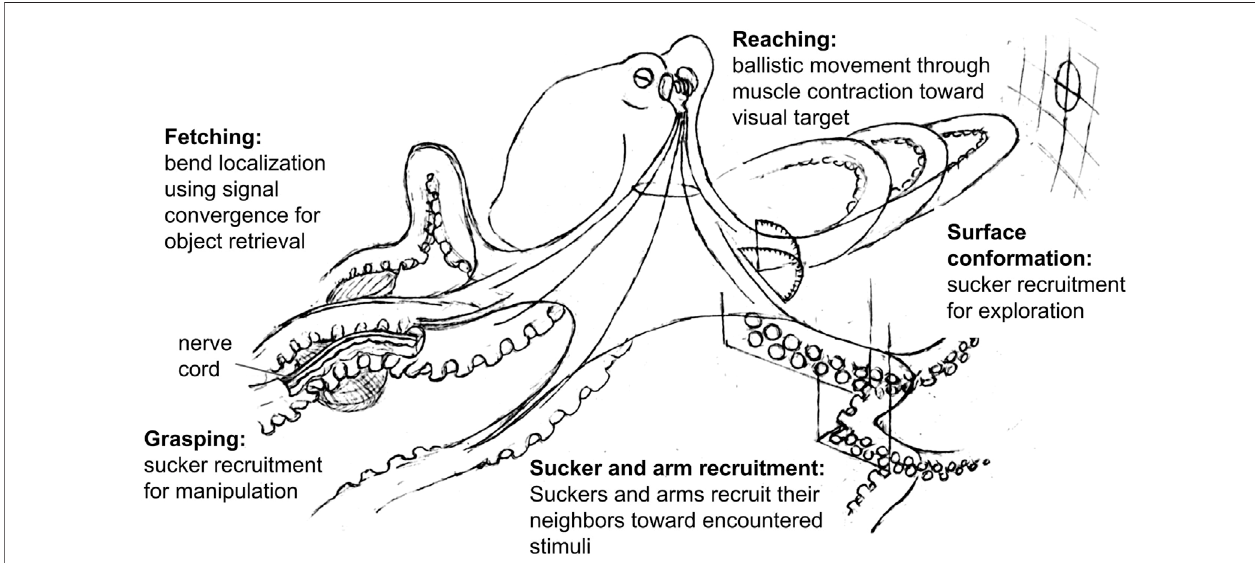
FIGURE 2 | Octopus arm control strategies. Fetching: from the base of the arm, an outbound wave of muscle activation converges with another inbound wave determinedbythelocationoftheobject(Sumbreetal.,2006).Armmusculatureisactivatedatthismidpoint,bendingthearmappropriatelytopasstheobjectproximally. Sucker recruitment: in response to a stimulus, suckers recruit their neighbors to bend toward this stimulus. These suckers can then recruit their neighbors as this mechanismcontinuesdownthearm(Rowell,1963;Altman,1968;Gutfreundetal.,2006;Zulloetal.,2011).Armrecruitment:inresponsetostimulationofonearm, the corresponding suckers on neighboring arms orient toward the site of stimulation (Graziadei, 1965b; Altman, 1968). Grasping: as suckers collectively adhere to an object,suckerrecruitmentprovides multipleafferent pathwaysforsensoryinputand multiple efferent pathways formanipulation. Ifthesuckers fi ndprey duringforaging, thesuckerswillrecruittheirneighborstocaptureandimmobilizetheanimal(Rowell,1963;Altman,1968;Gutfreundetal.,2006;Zulloetal.,2011).Surfaceconformation: assuckersrecruittheirneighborstowardencounteredsurfacefeatures,thearm ’ sshapeconformstothatofthesurface(Altman,1968;Kennedyetal.,2020).Reaching: using visual information the brain determines the horizontal and vertical angle (yaw and pitch) of the arm. The arm then extends by a wave of muscle contraction resembling a propagating bend toward the visual target (Gutfreund et al., 1998; Sumbre et al., 2001; Richter et al., 2015).